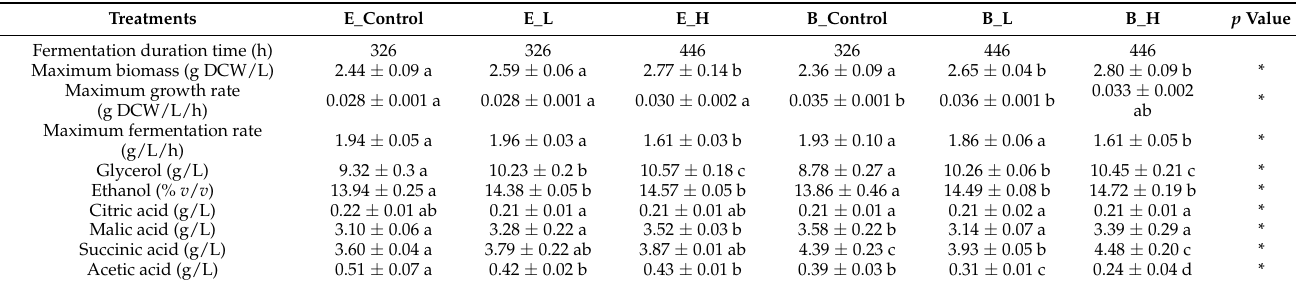
Table 1. Effects of different levels of unsaturated fatty acids (UFAs) mixtures on yeast fermentation activity and major fermentation products of EC1118 and BDX